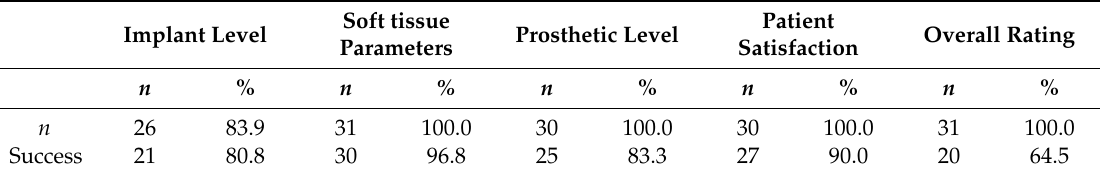
Table 6. Success criteria based on included parameters.